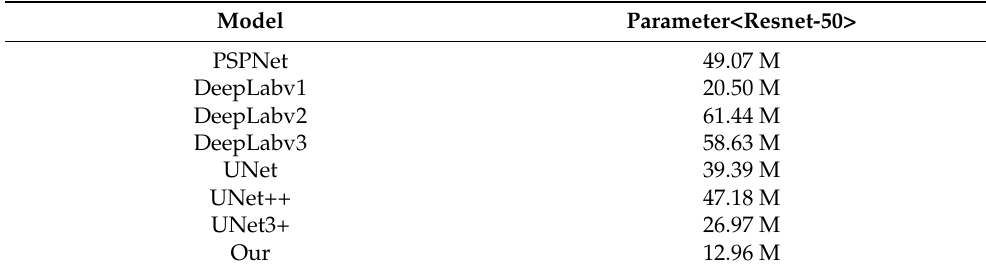
Table 3. Number of parameters per